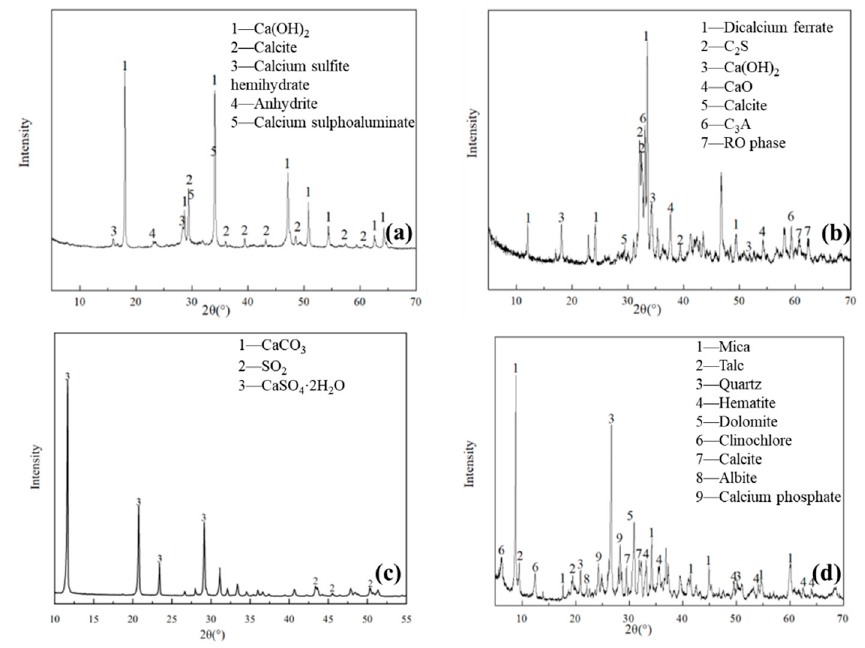
Figure 9. XRD spectra of raw materials: ( a ) desulphurised ash, ( b ) steel slag, ( c ) desulphurised gypsum and ( d ) tailings.